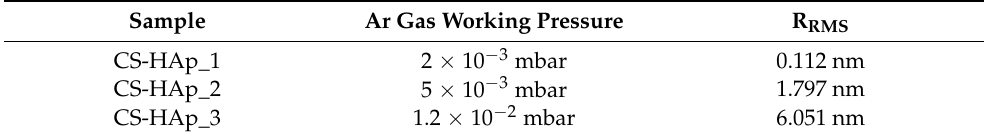
Table 2. Root mean square roughness (R RMS ) values for the CS–HAp coatings.